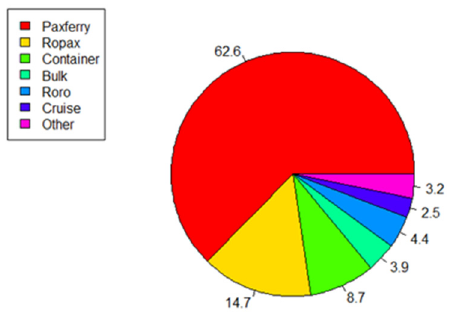
Figure 2. Mean ship visit shares by vessel type to port of Helsinki 2018–2021. Table 2. Ship visits to the port of Helsinki 2018–2020 by vessel type. Pax ferry: vessel that carries both roll-on roll-off cargo and passengers with the largest parts of the ship dedicated for passengers, ropax: vessel that carries both roll-on roll-off cargo with the largest parts of the ship dedicated for cargo, container: container vessel, roro: cargo vessel carrying roll-on roll-off cargo, cruise: cruise ship, other: all other vessel types.